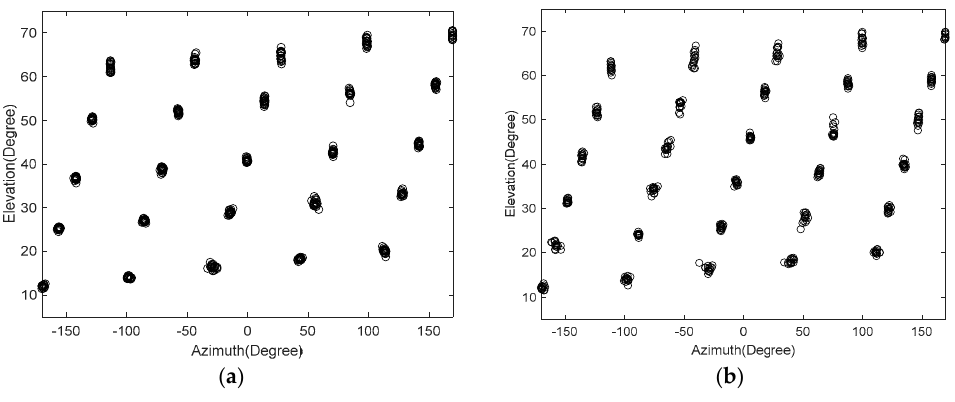
Figure 6. Distribution of azimuth and elevation estimation ( a ) K = 25 ( b ) K = 30. Simulation 2: RMSE comparison of the proposed algorithm using Unitary-ESPRIT and 2D-MUSIC, the PSS method, and the URA with the same number of sensors under different SNRs.